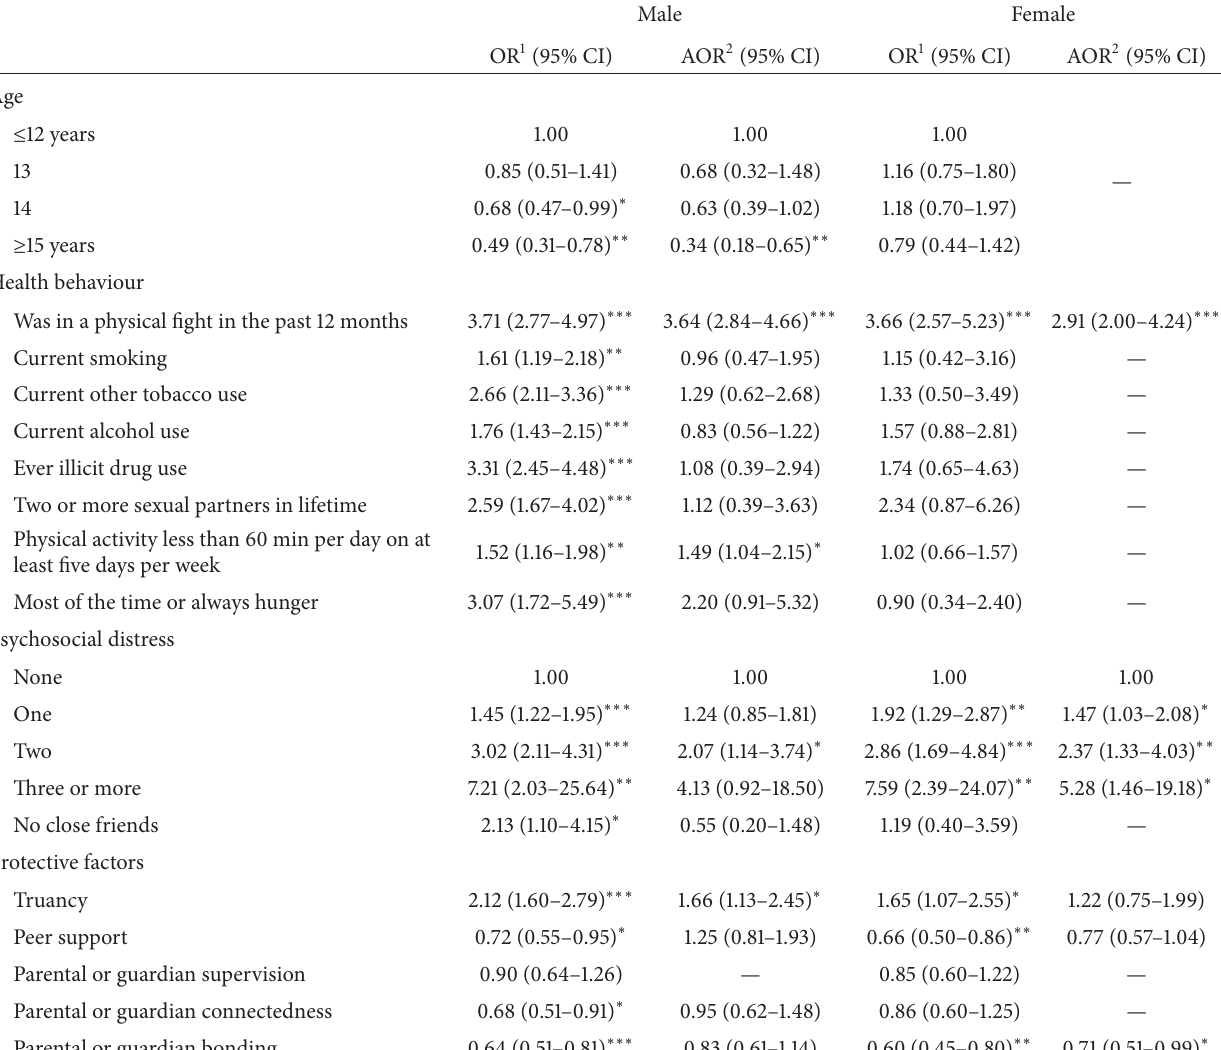
Table 2: Bivariate and multivariable logistic regression analysis of factors that are associated with bullying among adolescents in Thailand,